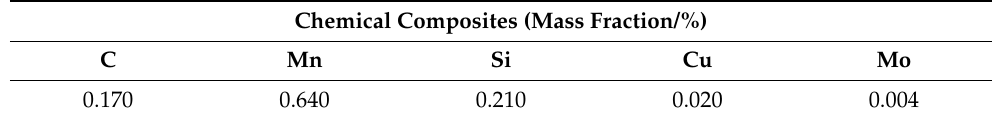
Table 1. Chemical composition of Grade A marine steel.